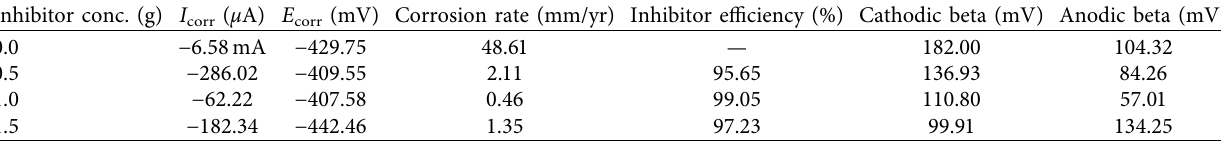
Table 3: Potentiodynamic polarization parameters at 30 ° C.